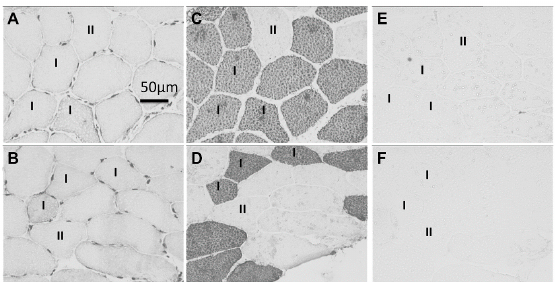
Figure 1. Small ubiquitin-related modifier (SUMO)-1 stained myofibre cross-sections in human skeletal muscle. ( A , B ) Skeletal muscle cross-section showing nuclear and sarcoplasmic staining of SUMO-1 antibodies in type I and II myofibres 15 and 30 min after resistance exercise, respectively; ( C , D ) Consecutive cross-sections stained for type I MyHc (A 4.840) showing type I (dark) and type II (bright) myofibres; ( E , F ) Consecutive cross-sections showing unstained negative controls of corresponding areas from ( A , B ).